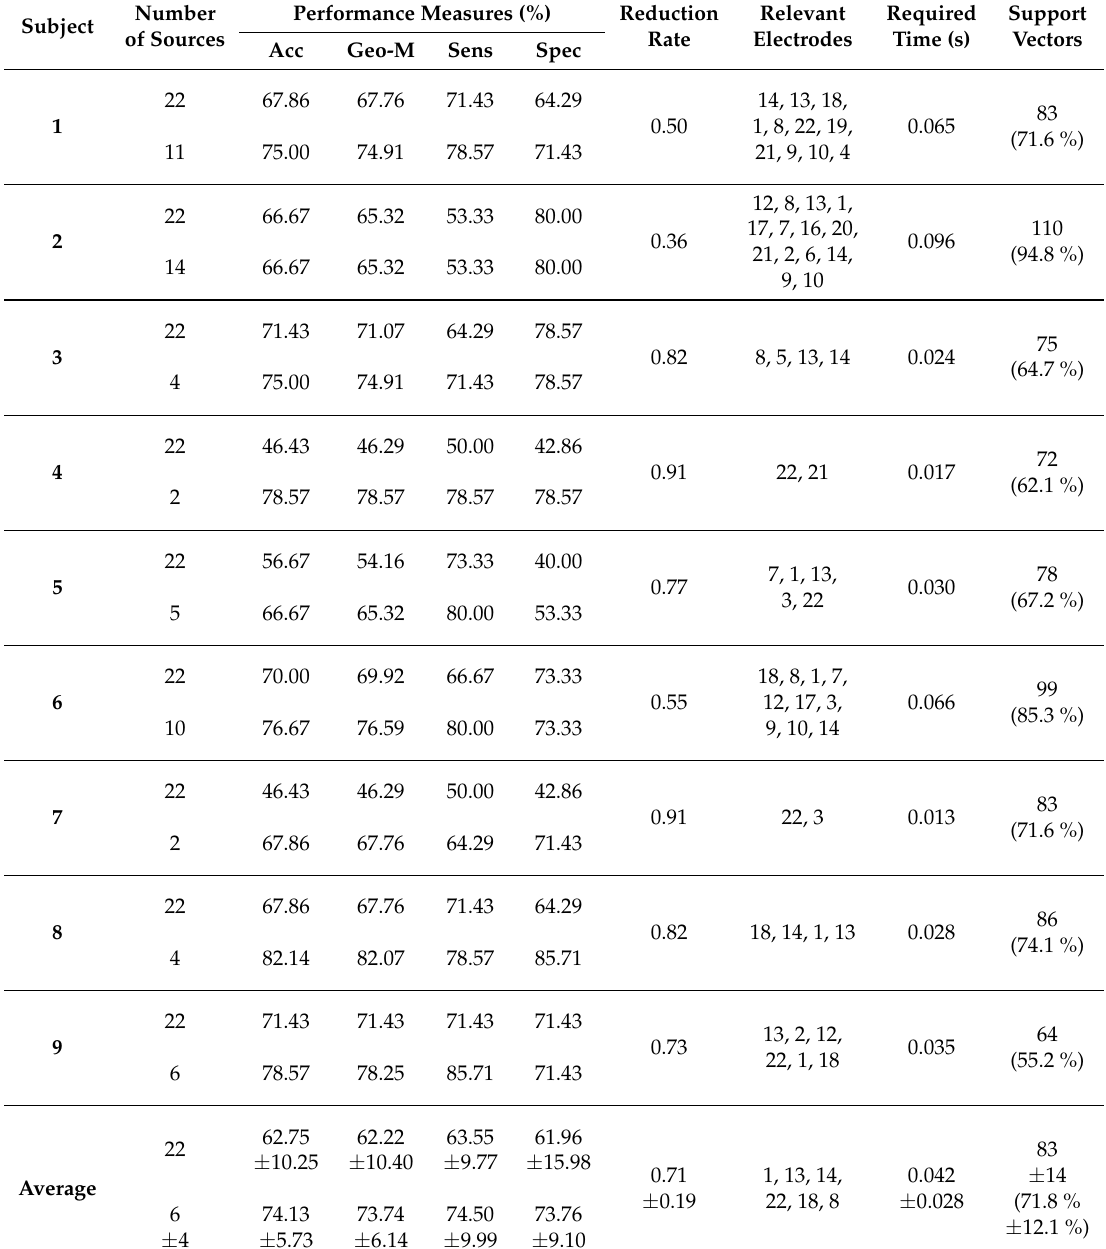
Table 2. Results of selection of BCI channels applying the Algorithm 2 and (cid:96) 2